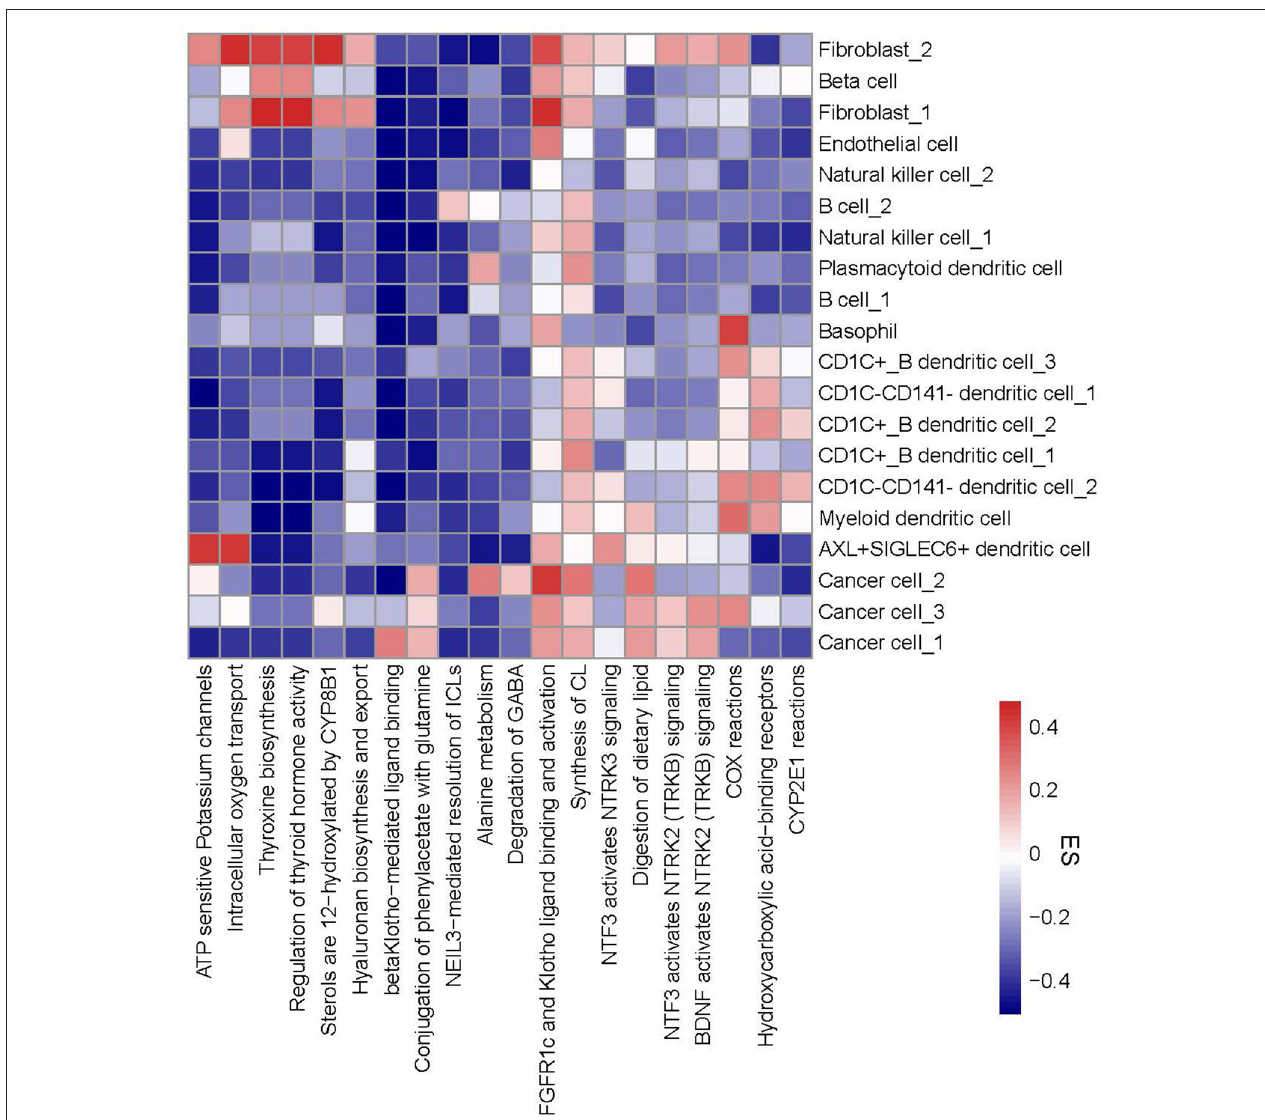
FIGURE 5 | A heatmap of functional pathways differentially enriched in 20 subgroups. Enrichment score from high to low was labeled as colors from red to blue. The right line indicates 20 subgroups and the bottom line indicates 20 functional pathways. ES, enrichment